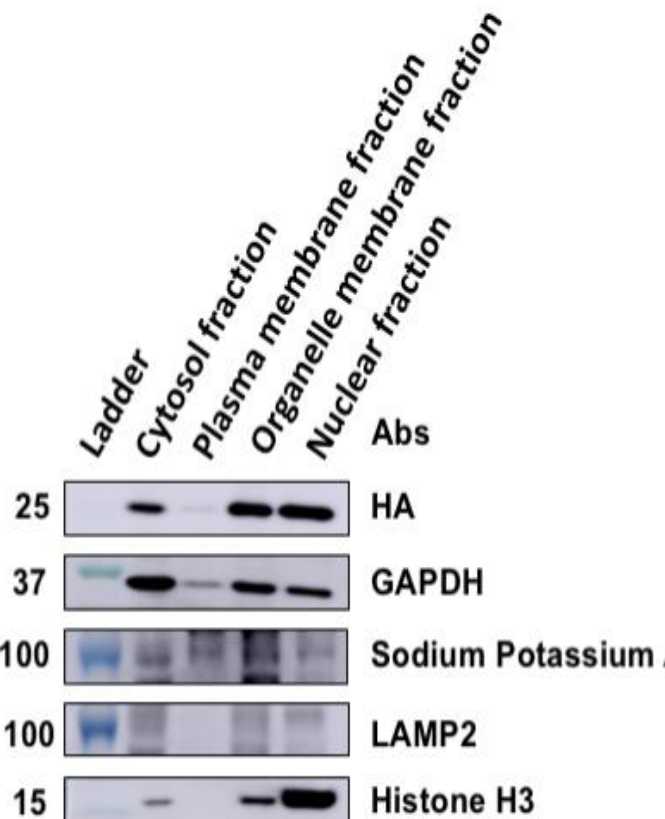
Figure 5. VP24 slightly associated with the plasma membrane fraction from HEK293 cells. The cellular membrane fractionation assay was performed with HA-VP24 detected in the cytosol fraction, organelle membrane fraction and nuclear fraction. Only a trace amount of eVP24 was detected in the plasma membrane fraction.